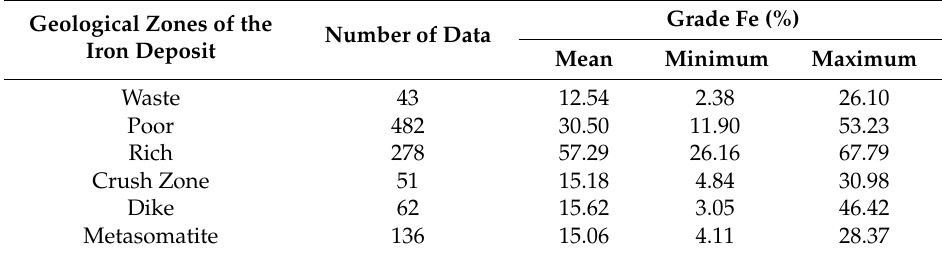
Figure 4. The proportions of the grades data in different geologic domains. (a) shows the overlapping of poor, rich and other geological zones, (b) shows the overlapping for waste, metasomatite and other geological zones. Table 2. Statistical parameters of Fe samples in six geologic domains. Table 2. Statistical parameters of Fe samples in six geologic domains.